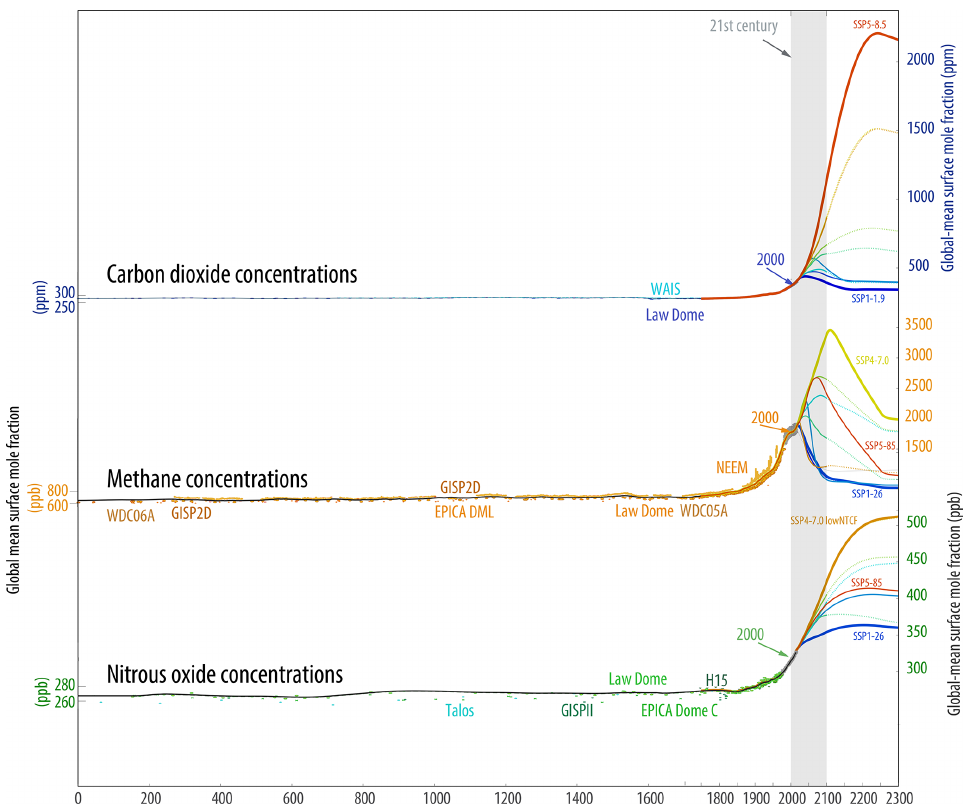
Figure 8. Overview of SSP concentrations of CO 2 , CH 4 , and N 2 O in the context of the historical observational dataset. For the respective main ice core and firn datasets (WAIS, Law Dome, EPICA DML, etc.), please see Fig. 6b in Meinshausen et al. (2017). The 21st century is shown as a grey vertical